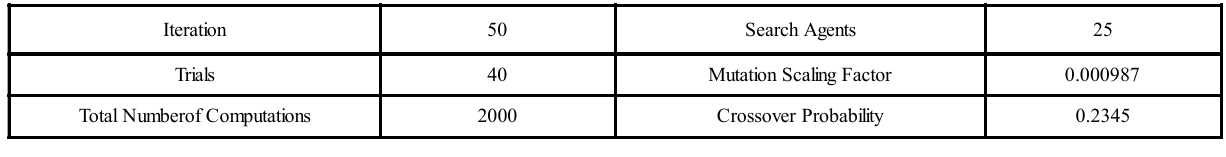
TABLE 4. LIST OF PARAMETERS TAKEN FOR TEST